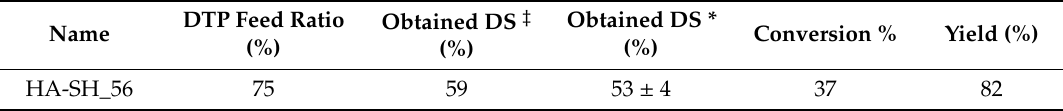
Table 2. Overview of the main characteristics of thiolated hyaluronic acid (HA-SH)_56, as determined by 1H-NMR and Ellman’s